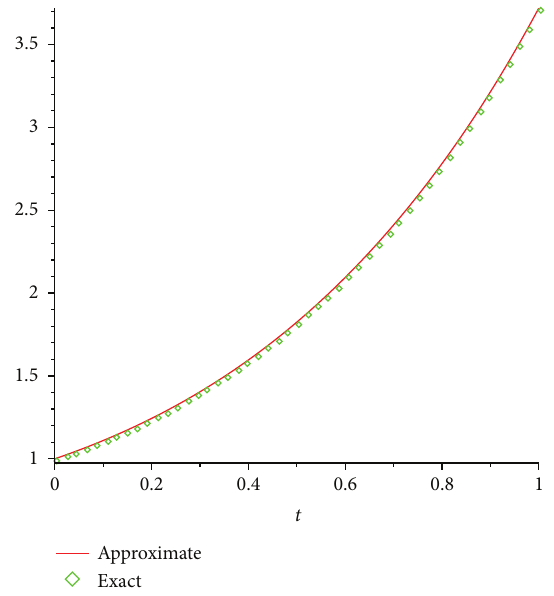
Figure 1: Graphs of the exact and computed solution of the problem for Example